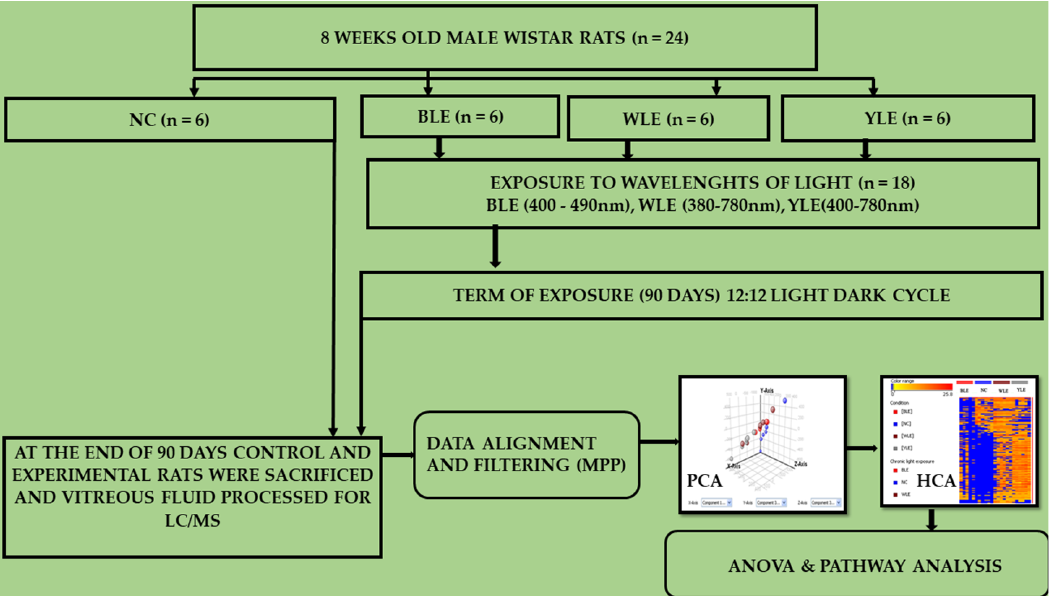
Figure 1 : Explains the methodological flow and data analysis ofnormal controls (NC), blue light exposure (BLE), white light exposure (WLE), and yellow light exposure (YLE)